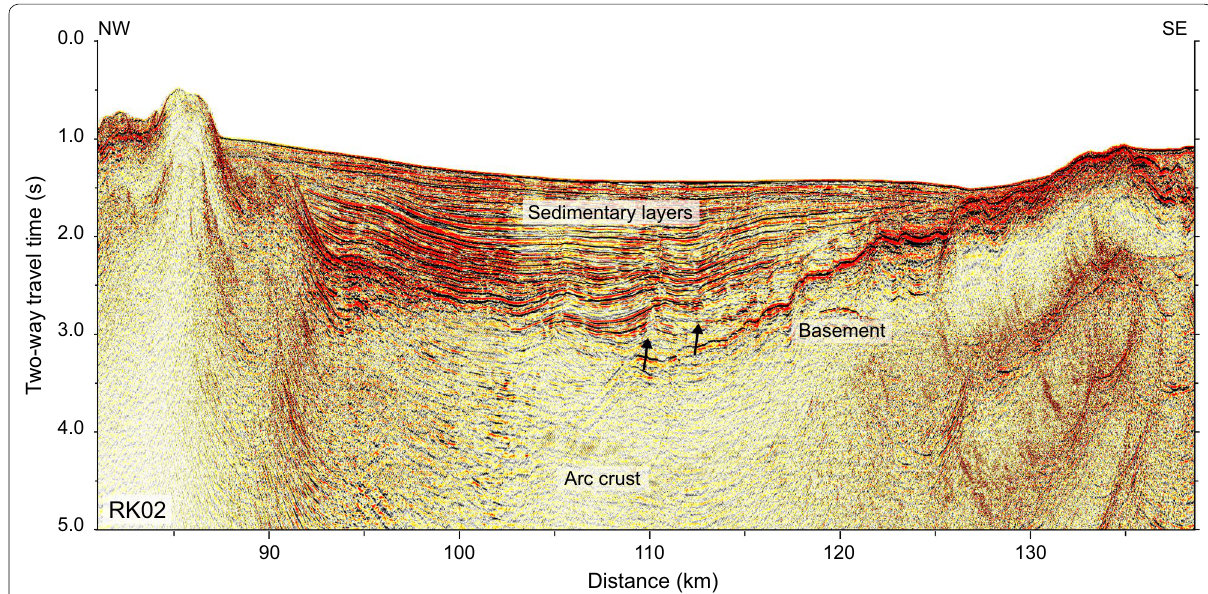
Fig. 4 Seismic reflection image of the RK02 profile focusing on the Tokara Channel. The acoustic basement marked by high-amplitude reflections forms a ~ 30-km-wide bowl-shaped basin with the maximum depth of ~ 2 s two-way travel time (equivalent to ~ 3 km) relative to the adjacent non- volcanic arc segment. The basin is filled with subhorizontal reflectors indicative of sedimentary units deposited on the arc crust. The sedimentary layers show a downward convex geometry and step-like features across the layers as indicated by black arrows. The acoustic basement also exhibits multiple steps in the southeastern part of the basin